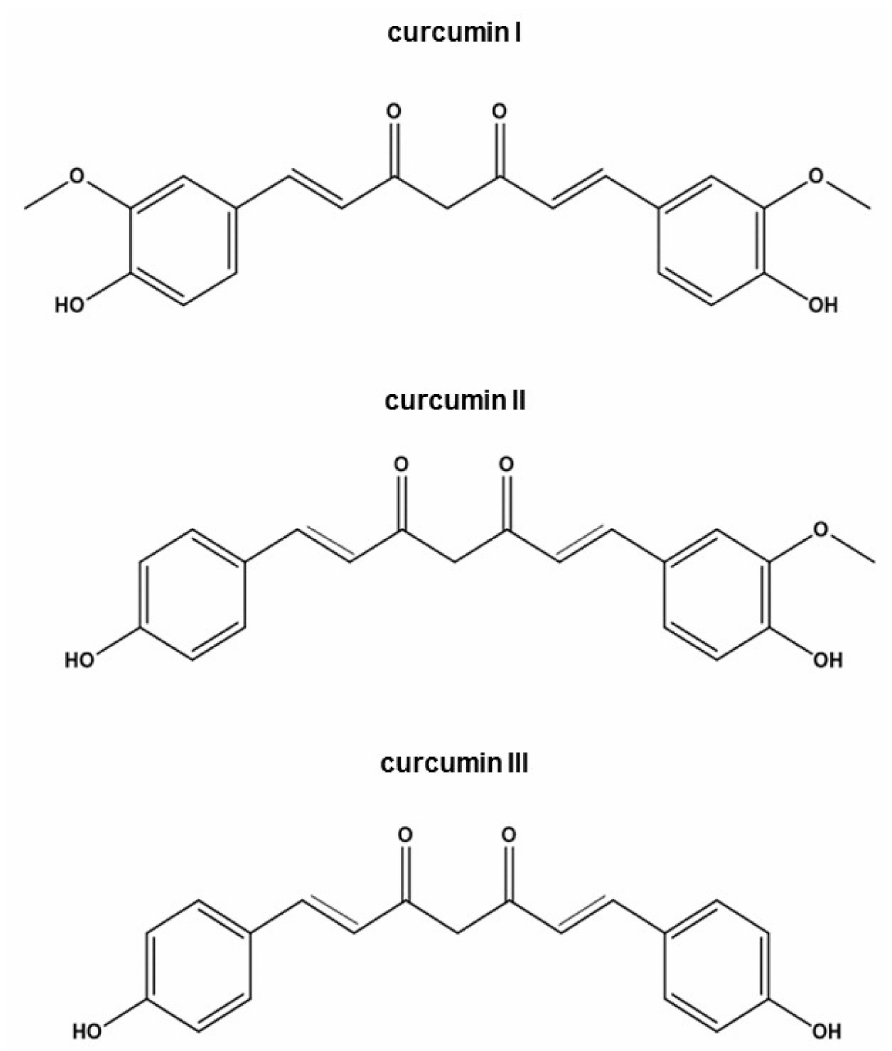
Figure 1. Chemical structures of curcumin I, II, III. Despite curcumin’s anticancer potential, its therapeutic application is limited by its poor bioavailability, due to the low or very low absorption after oral intake. After oral administration, curcumin is metabolized into curcumin glucuronide and curcumin sul- fonate by the liver during phase II reactions. Glucuronidation and sulfation increase curcumin’s water solubility, but decrease its effectiveness and accelerate its removal via urine [20]. Specifically, the different factors contributing to the low bioavailability